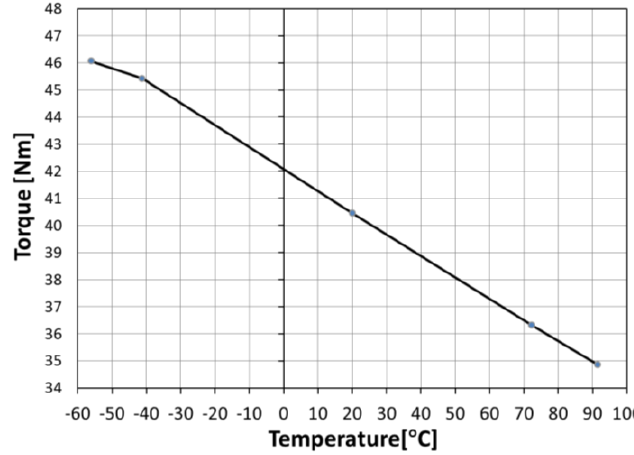
Figure 13. Sliding torque with respect to the temperature.